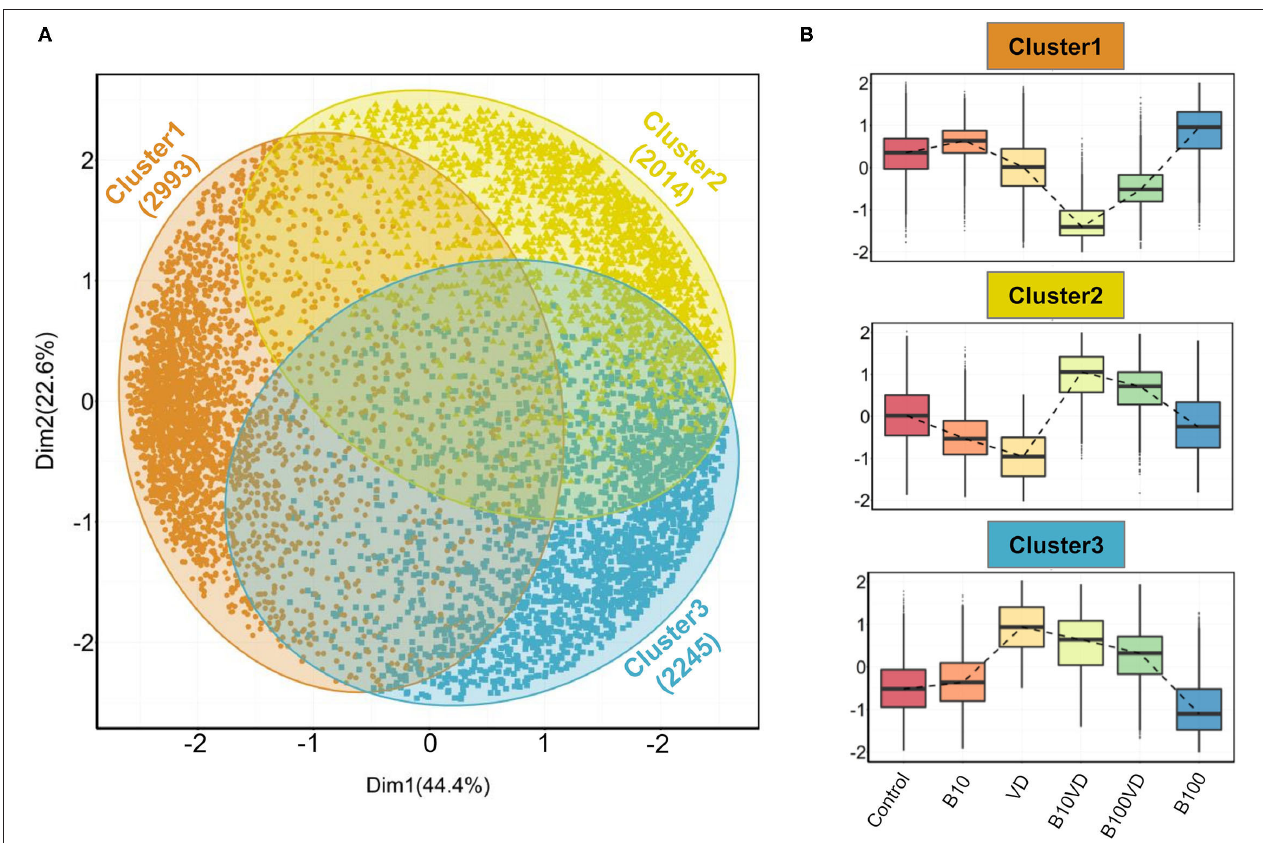
FIGURE 3 | Outputs from PAM clustering of all the DEGs. (A) PCA visualizing the three clusters labeled cluster 1, cluster 2, and cluster 3 (indicated in orange, yellow, and blue colors, respectively) as defined by the PAM clustering. (B) Expression patterns of normalized gene expression values across different treatment groups in each of the three clusters. The expression counts were mean-centered before plotting them as box plots. The dashed lines within each panel connect the median values across different treatment